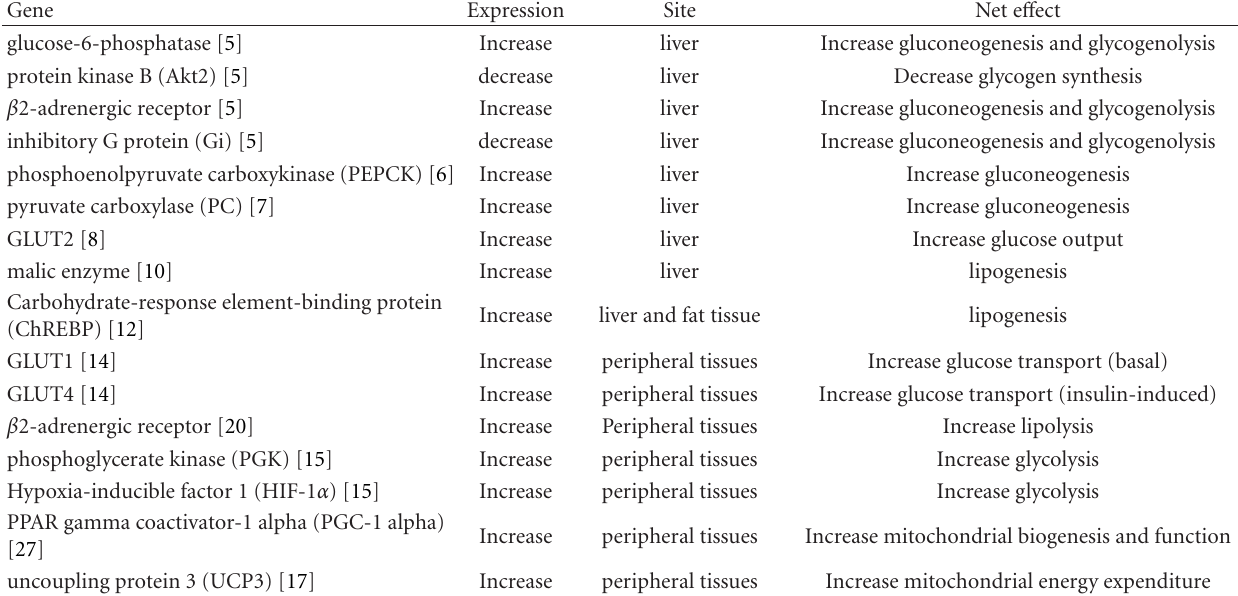
Table 1: Direct e ff ects of T3 on genes that regulate glucose homeostasis at the liver and peripheral tissues (muscle, fat tissue, and fibroblasts). Gene Expression Site Net e ff ect glucose-6-phosphatase [5] Increase liver Increase gluconeogenesis and glycogenolysis protein kinase B (Akt2) [5] decrease liver Decrease glycogen synthesis β 2-adrenergic receptor [5] Increase liver Increase gluconeogenesis and glycogenolysis inhibitory G protein (Gi) [5] decrease liver Increase gluconeogenesis and glycogenolysis liver Increase